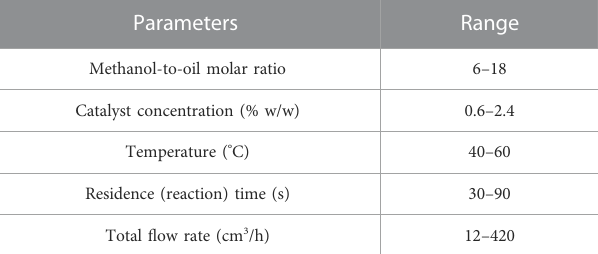
TABLE 2 Experimental conditions for the production of